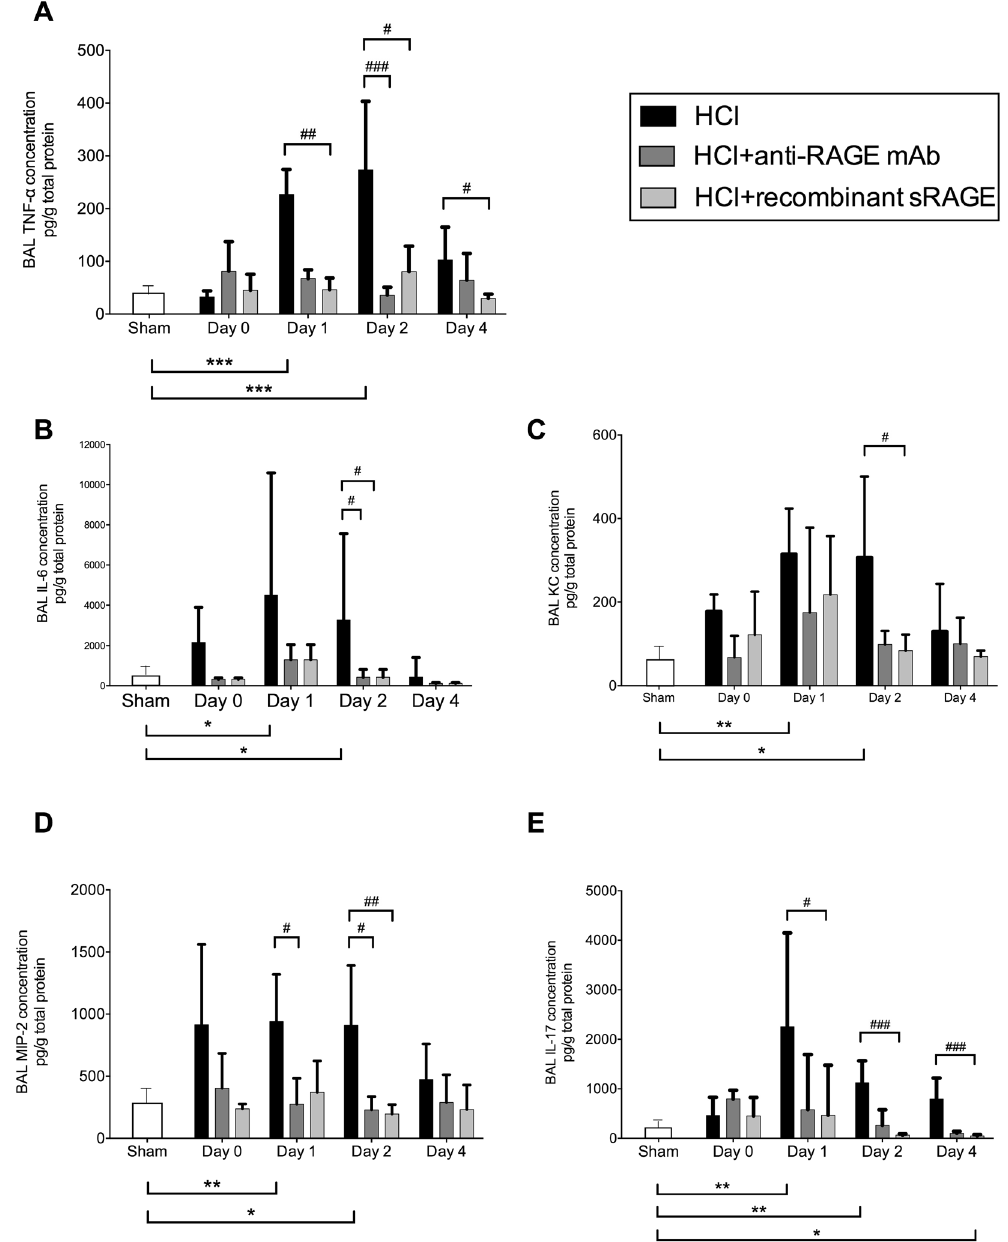
Figure 4. Anti-inflammatory effects induced by RAGE inhibition. Measurement of bronchoalveolar (BAL) levels of (A) interleukin (IL)-6, (B) tumor necrosis factor (TNF)- α , (C) keratinocyte-derived chemokine (KC), (D) macrophage inflammatory protein (MIP)-2 and (E) interleukin (IL)-17 in uninjured, untreated mice (Sham group), acid-injured animals (HCl group) and acid-injured animals treated with sRAGE (HCl + recombinant sRAGE group) or with anti-RAGE monoclonal antibody (HCl + anti-RAGE mAb group) (n = 4–6 for each time-point). Levels of cytokines were normalised to those of total protein. As no difference was observed between sham animals at all time points; the results from sham mice were mixed for analyses (left bar of the X-axis). Values are reported as means ± standard deviations. * P < 0.05; ** P < 10 − 2 ; *** P < 10 − 3 versus sham controls; # P < 0.05; ## P < 10 − 2 ; ### P < 10 − 3 versus acid-injured